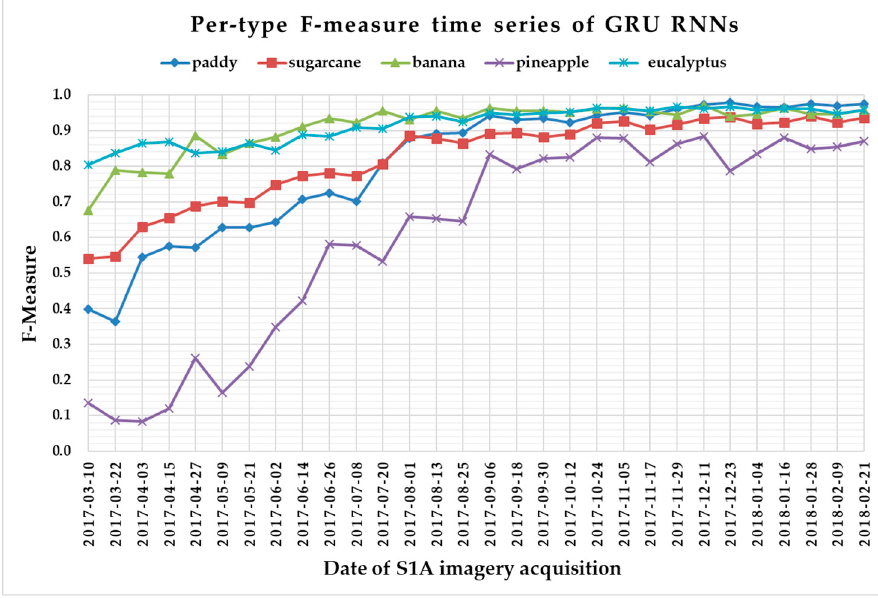
Figure 15. F-measure time series of gated recurrent unit recurrent neural networks.